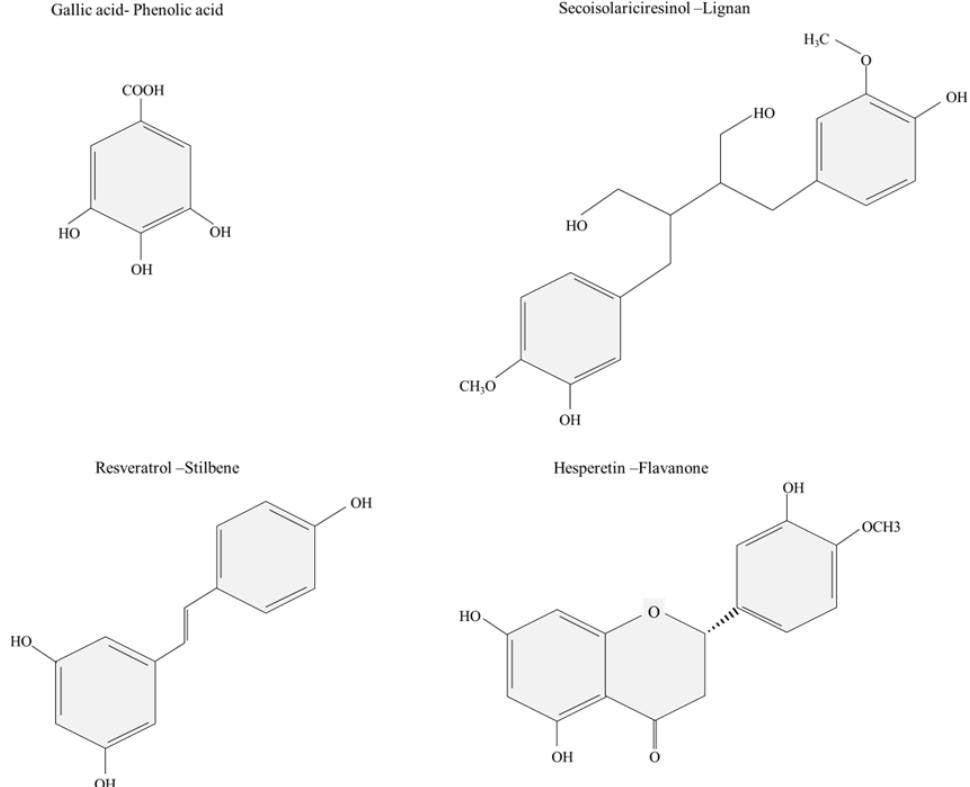
Figure 1. Examples of principal polyphenolic compounds clustered in phenolic acids (gallic acid) [14], lignans (secoisolariciresinol) [3], stilbenes (resveratrol) [15], and hesperetin (flavanone) [3].